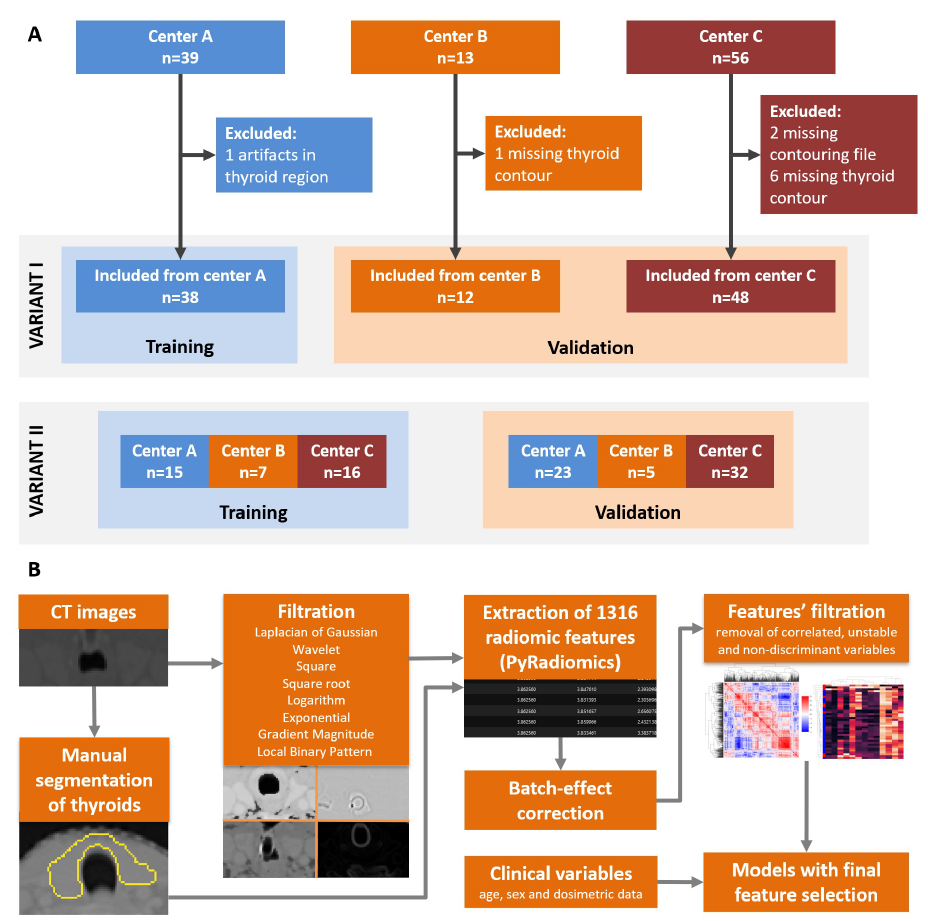
Figure 1. Summary of patients’ selection and data subsets ( A ). Outline of the study from image segmentation to NTPC model derivation ( B